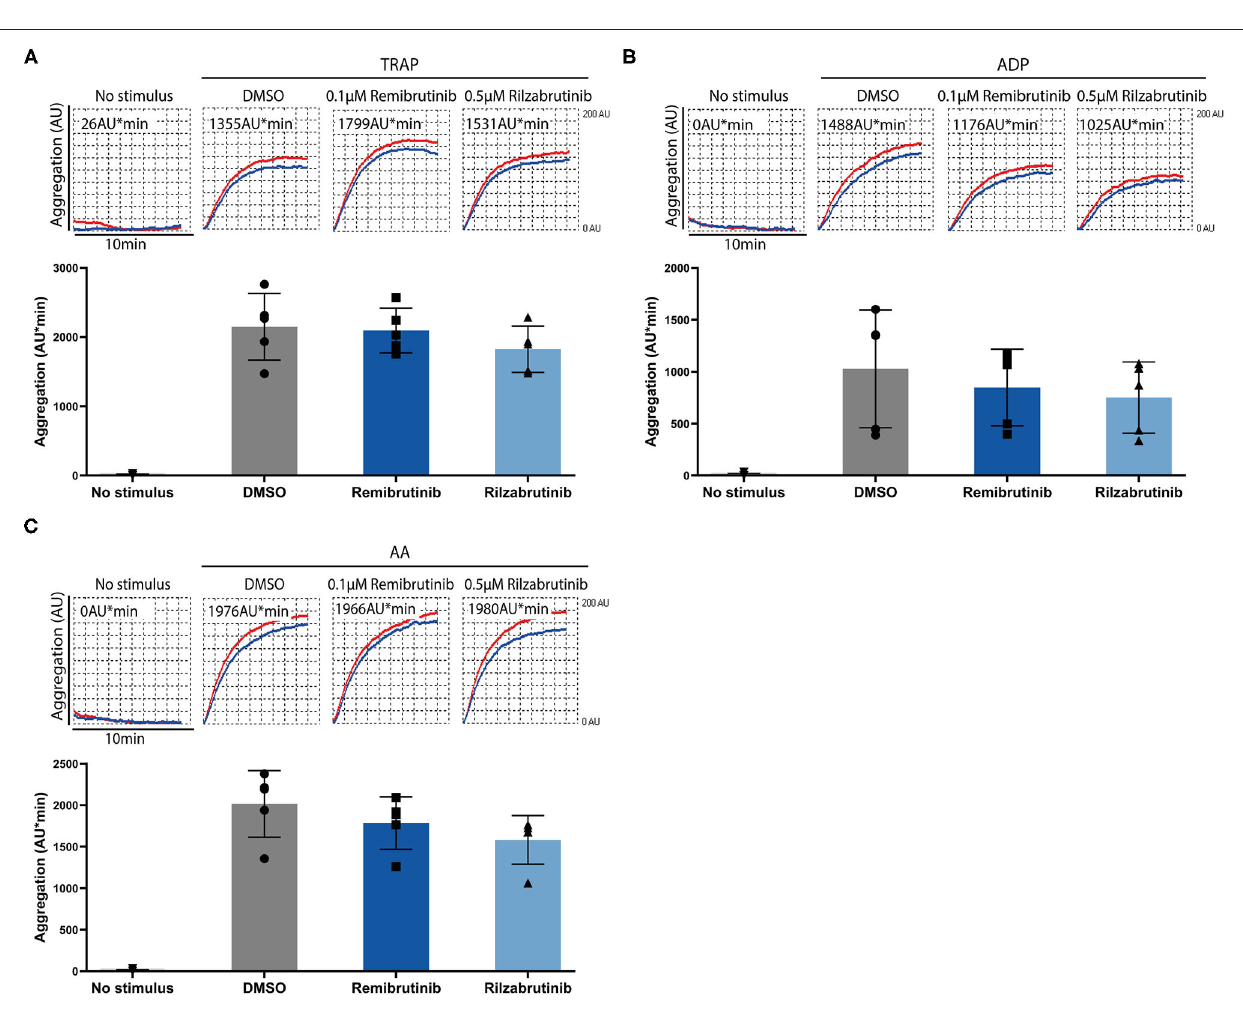
FIGURE 3 | Effects of remibrutinib and rilzabrutinib on platelet aggregation in blood after stimulation by TRAP, ADP, or AA. Hirudin anticoagulated blood samples were pretreated for 1h at 37 ◦ C with solvent control (DMSO, 0.1%), or BTKi (remibrutinib 0.1 µ M, rilzabrutinib 0.5 µ M) before stimulation with (A) TRAP (15 µ M), (B) ADP (10 µ M), or (C) AA (0.6mM). Representative MEA tracings (top panels) and aligned dot blot bar graphs (bottom panels) are shown. Values shown are mean ± SD ( n = 5). Statistical analysis was carried out using ordinary ANOVA followed by Bonferroni’s test (A,B) or Kruskal-Wallis test followed by Dunn’s test (C) , that did not show significant